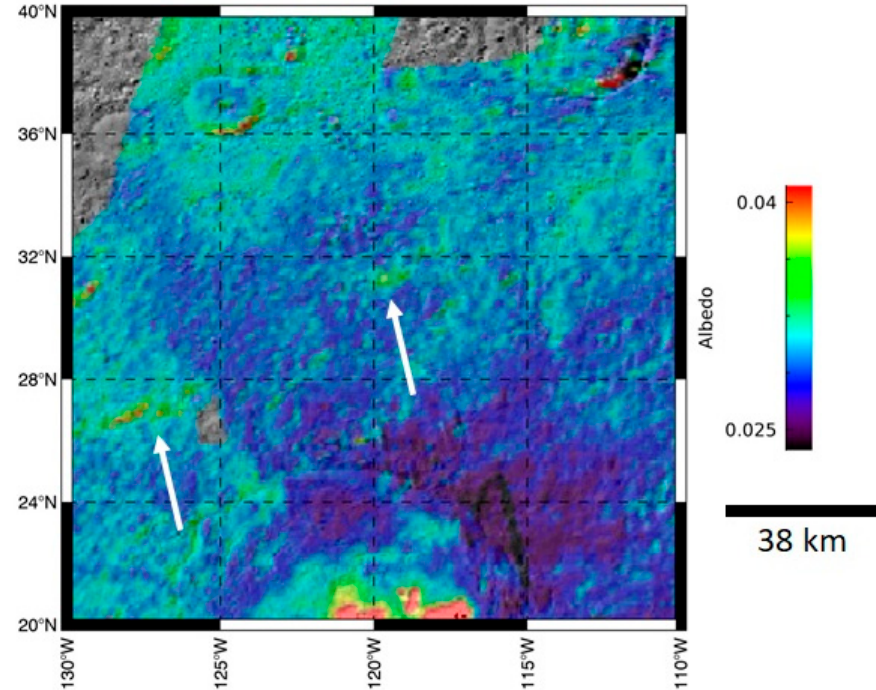
Figure 4. NIR albedo cylindrical map of the region north of the Occator crater. Arrows indicate an increase in albedo corresponding to the Junina Catenae linear feature locations. Scale bar refers to the latitude at the map center.